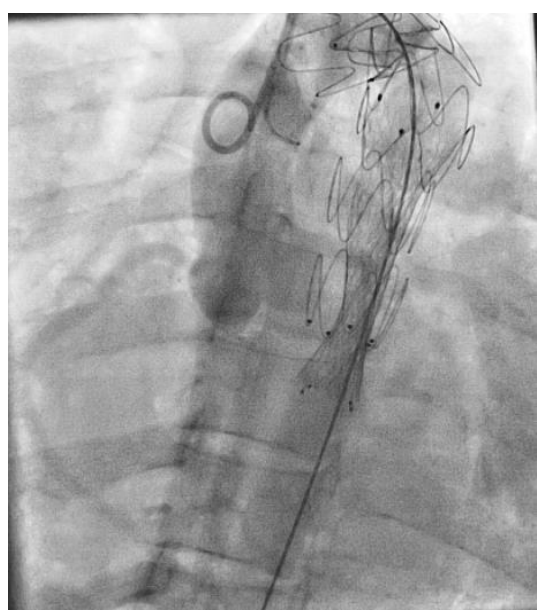
Figure 4A. Stent implantation inside the distal part of the stenotic endograft post-dilated with a 20 × 40 mm Zelose balloon with good technical results. An inner lumen was descending aorta (figures 4A and